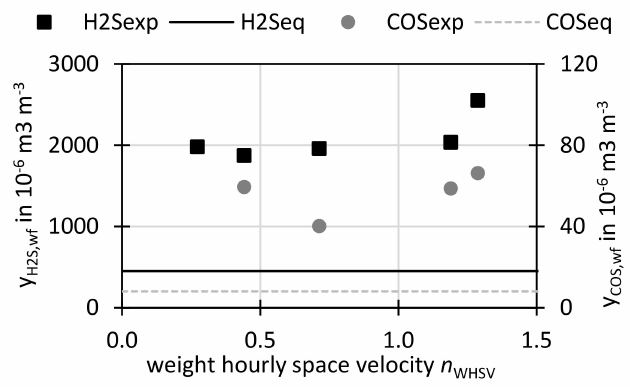
Figure 15. Measured and equilibrium H 2 S and COS concentration at different fuel space velocities.